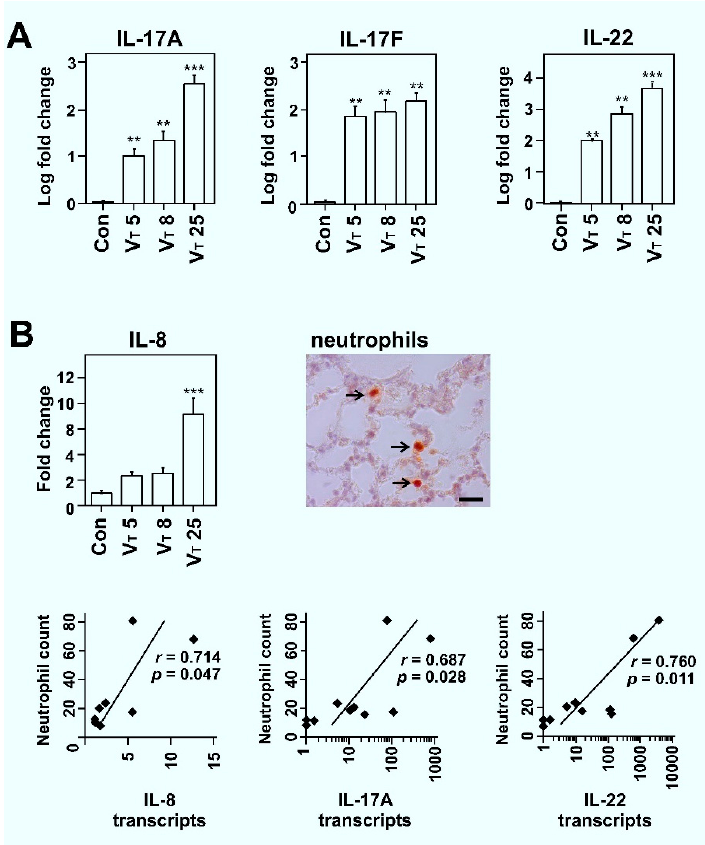
Figure 1. Effect of mechanical ventilation on transcript levels of IL-17A , IL-17F , IL-22 , and IL-8 and correlations with tissue neutrophils. ( A ) IL-17A , IL-17F , and IL-22 lung transcripts analyses of spontaneously breathing control (Con), and in tidal volume (V T ) 5, V T 8, and V T 25 mL/kg ventilation groups of Wistar rats analyzed after 2 h of mechanical ventilation (MV). Data is presented as averages ± standard error of mean (SEM); * p < 0.05, ** p < 0.01; and *** p < 0.001; asterisk above the error bars denotes significance against spontaneously breathing control group; n = 6 animals per group. ( B ) A similar IL-8 lung transcript analysis and Spearman correlation between lung neutrophil counts (neutrophils were detected with an anti-neutrophil antibody; scale bar, 20 μ m; arrow indicates neutrophils) and transcript levels of IL-8, IL-17A , and IL-22 ( n = 10 animals per group).